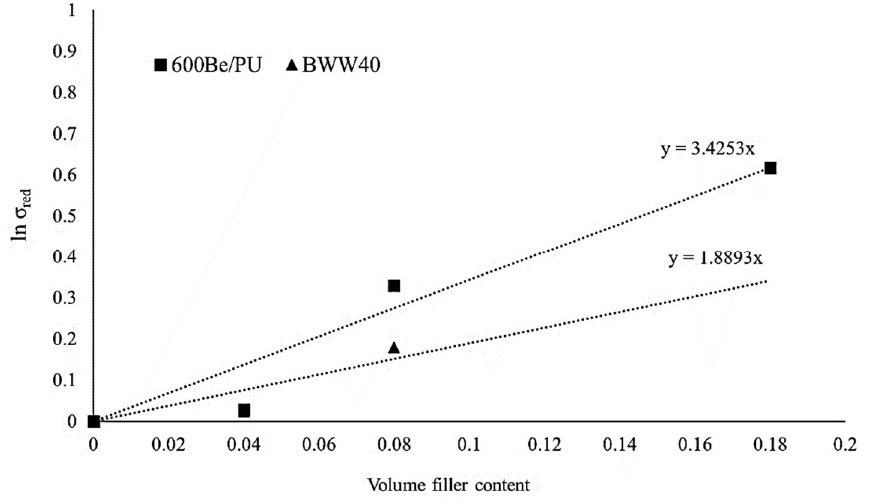
Figure 3. Pukánszky’s plot for PLA–Arbocel ® composites.